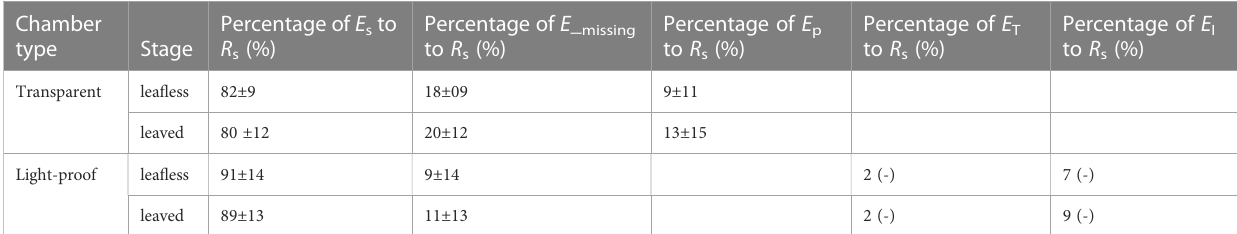
TABLE 3 Partitioning percentages of culm-respired CO 2 ef fl ux fl owing to the four pathways, i.e., surface ( E s ), photosynthesis ( E p ), sap fl ow ( E T ), and internal storage ( E I